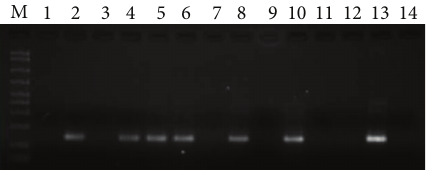
Figure 1: HPV detection assay. This figure shows the electrophotetic profile of 12 representative cases assayed by nested PCR for the detection of HPV L1 . Cases 2, 4, 5, 6, 8, and 10 are positive as demonstrated by the presence of the amplicon generated by the GP 5+/6+ primer pair. Lane M is the molecular size marker; lanes 13 and 14 were HPV positive and water controls,